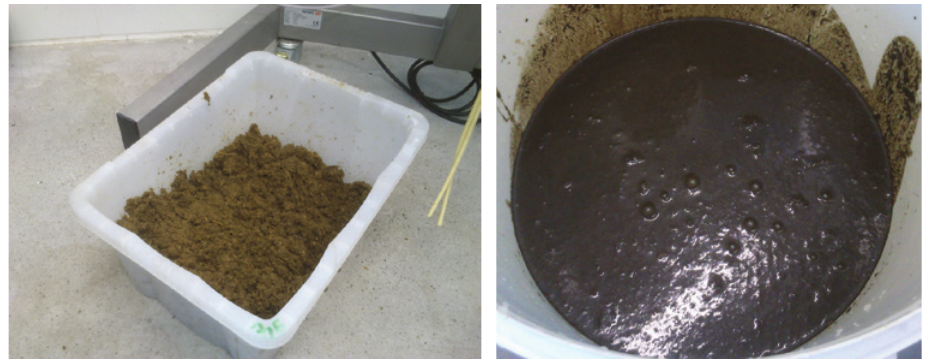
Figure 1: Cattle slurry separated solids and the liquid inoculum.